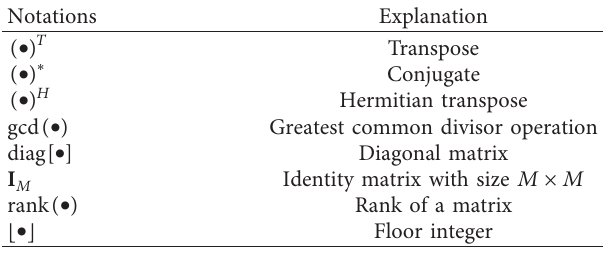
Table 1: Key notations used in this